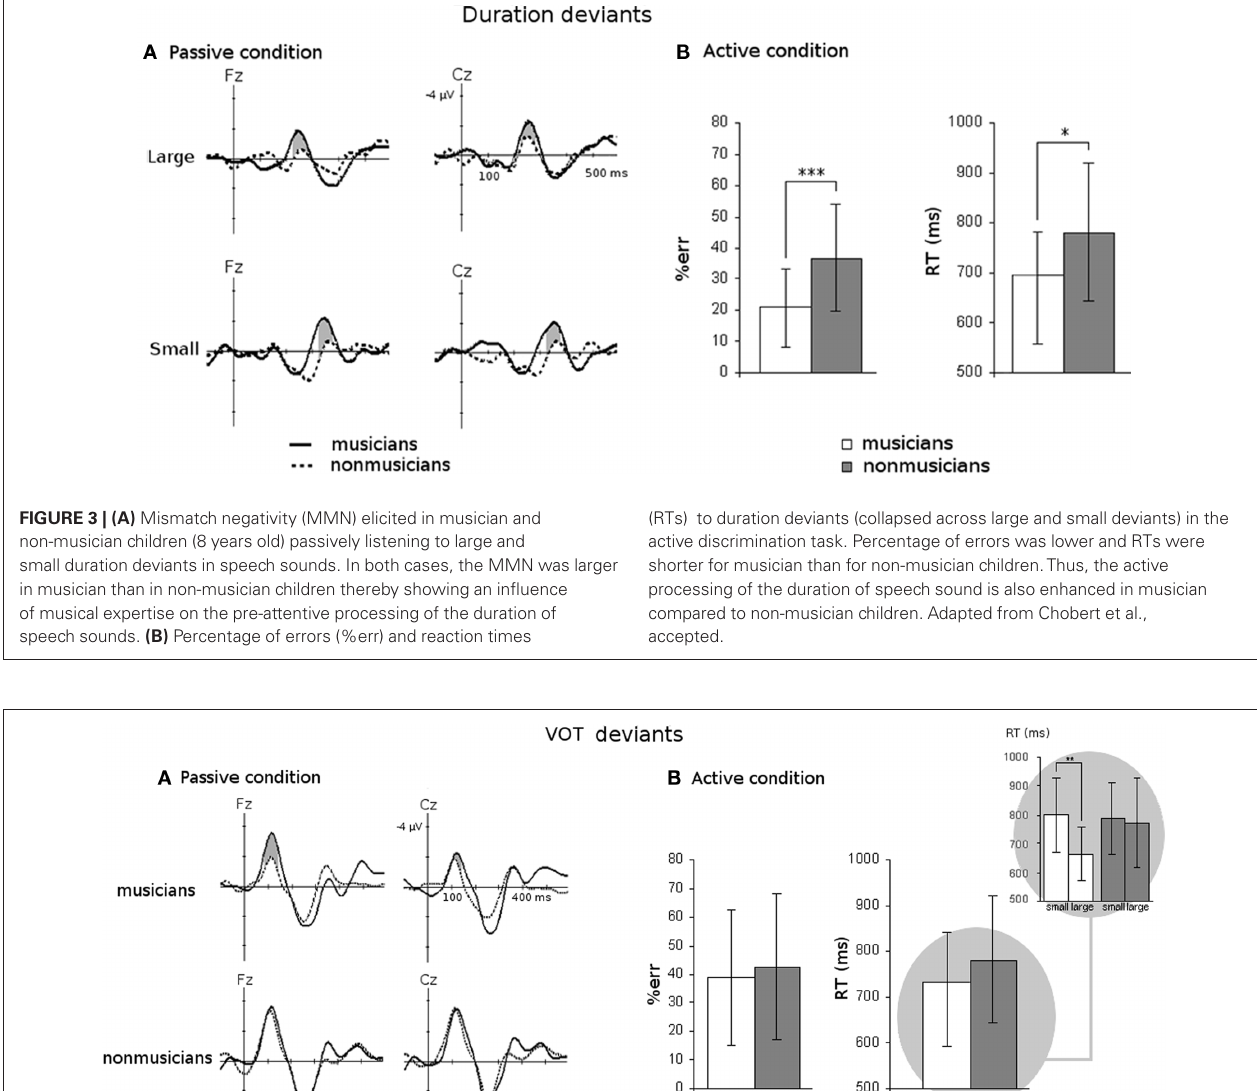
(B) Percentage of errors (%err) and reaction times (RTs) to VOT deviants (collapsed across large and small deviants) in the active discrimination task. No difference between musician and non-musician children were found on %err but, as found for MMN amplitude, the deviant size effect was significant on RTs for musician children with shorter RTs to large than to short deviants and with no difference for non-musician children. Adapted from Chobert et